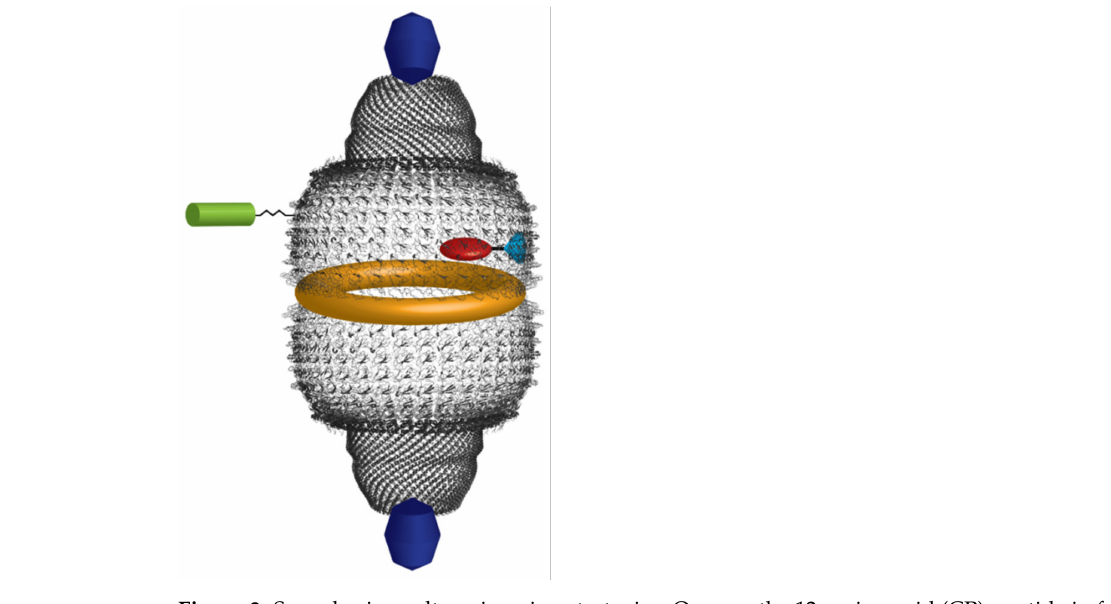
Figure 3. Some basic vault engineering strategies. Orange: the 12-amino-acid (CP) peptide in fusion at the MVP N-terminus confers much greater nanoparticle regularity and stability. Purple: proteins genetically fused at the N-terminus of the INT domain (green) are packaged into the vaults for facilitated delivery (e.g., the pVI endosomolytic peptide, the CCL21 chemokine, the immunogenic major outer membrane protein (MOMP), and PmpG proteins, fluorescent proteins, the NY-ESO-1 peptide, which stimulates the maturation of dendritic cells). Blue: peptides in fusion with MVP C-terminus are exposed on the surface of the nanoparticle and can either target it to specific cell receptors (e.g., EGF, the Z domain of protein A, which can bind any IgG) or facilitate its cellular uptake (e.g., pVI and the cell-penetrating peptide TAT48). Red: different proteins, such as TAT48 or fluorescent probes, can be covalently attached to MVP subunits via suitable